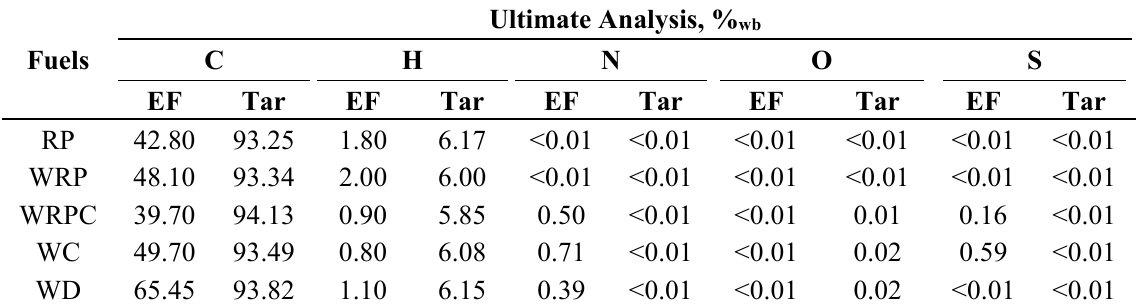
Table 5. Elutriated fines composition produced during the gasification